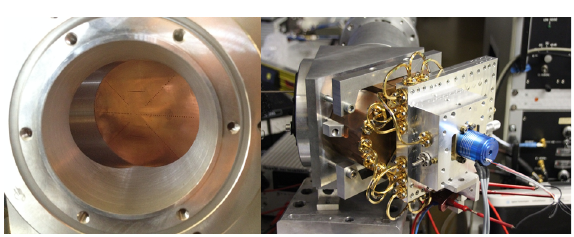
Figure 16. Assembled multiport coupler prototype diagnostic system consisting of the multiport coupler and the waveguide based signal processing unit. This unit is using a rotating grat- ing and a coupling plate with integrated Talbot e ff ect splitter as illustrated in Fig. 9.